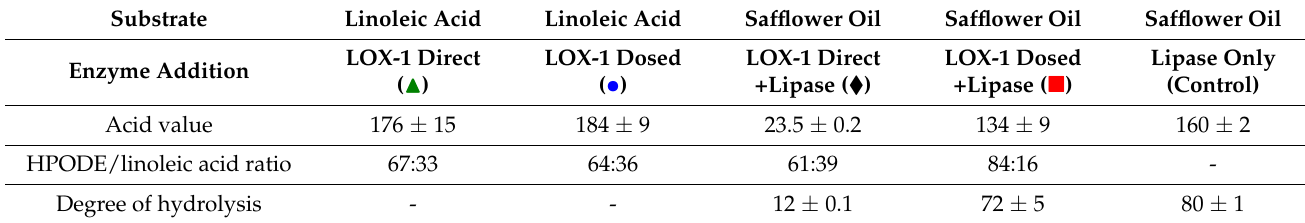
Table 2. Analysis of HPODE formation and degree of hydrolysis of comparative hydroperoxidation experiments shown in Figure 4a; Acid value was determined by titration of the lipid phase (Figure S6), HPODE ratio to residual linoleic acid was derived from GC analysis (Figure S8) and degree of hydrolysis was calculated from average molecular weight after hydroperoxidation and acid